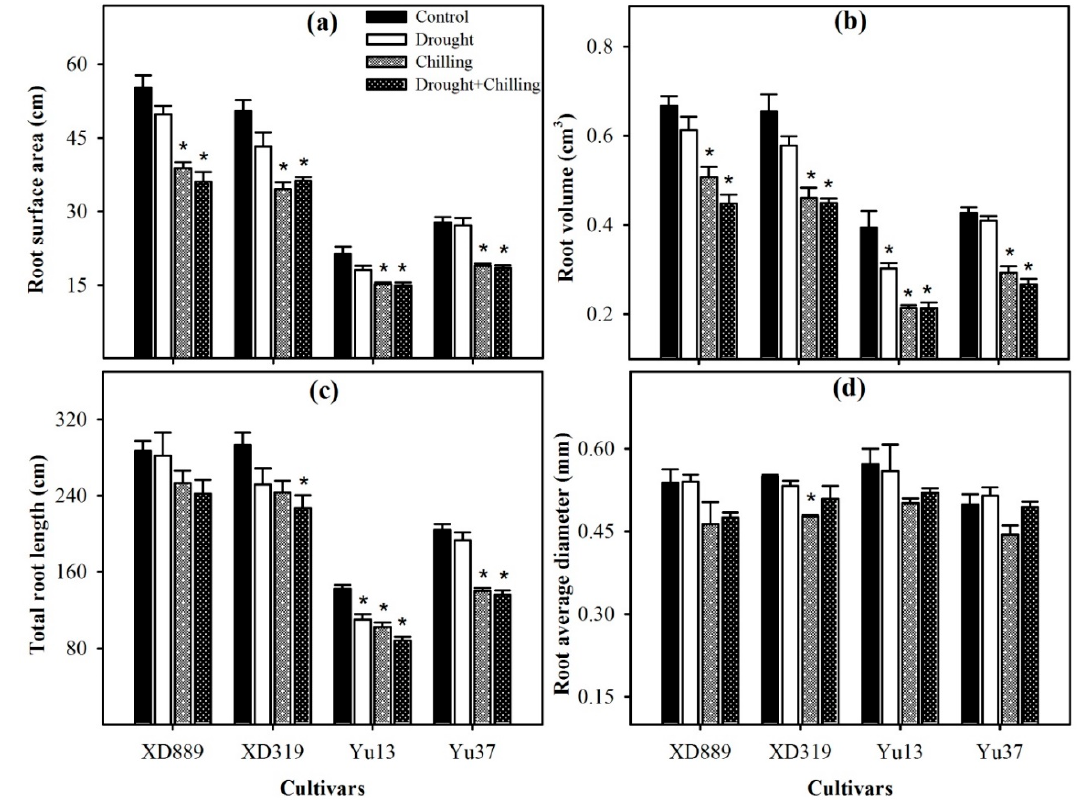
Figure 6. Root surface area ( a ), root volume ( b ), total root length ( c ), and root average diameter ( d ) of four maize cultivars as influenced by the drought, chilling, and drought + chilling stresses. Vertical bars above mean indicate standard error of three replicates. Mean value for each treatment with * indicate significant differences compared with control according to LSD test ( P ≤ 0.05).